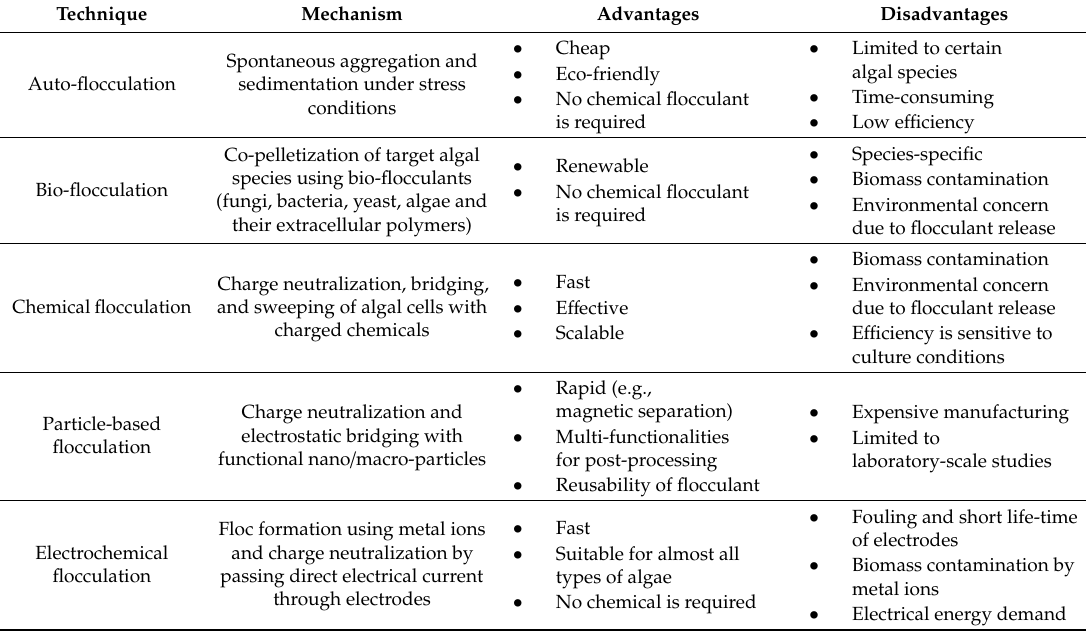
Table 6. Comparison of five flocculation techniques for algae